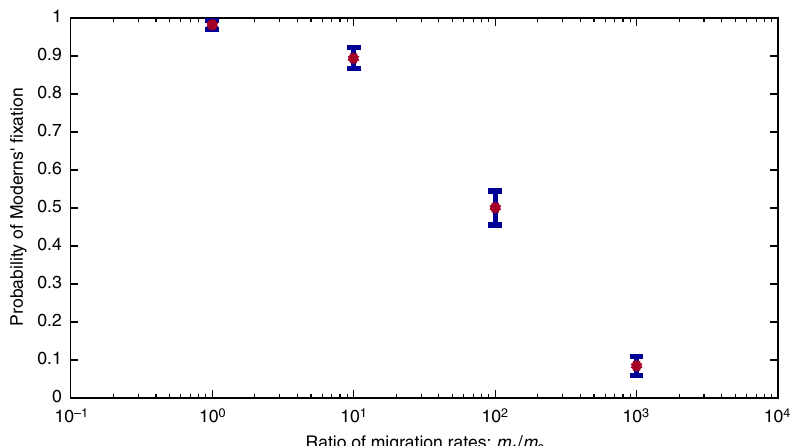
Fig. 5 Under bidirectional migration, fi xation probability depends on migration rates. The probability of Moderns ’ replacement of the Neanderthals for a range of ratios between the migration parameters, m 1 /m 2 , with a constant ratio of population sizes (brown; blue bars indicate two standard errors around the observed frequency of fi xation). For all runs, N 1 = 50, N 2 = 500, m 2 = 5 × 10 − 6 . 500 simulation replicates were conducted for each value